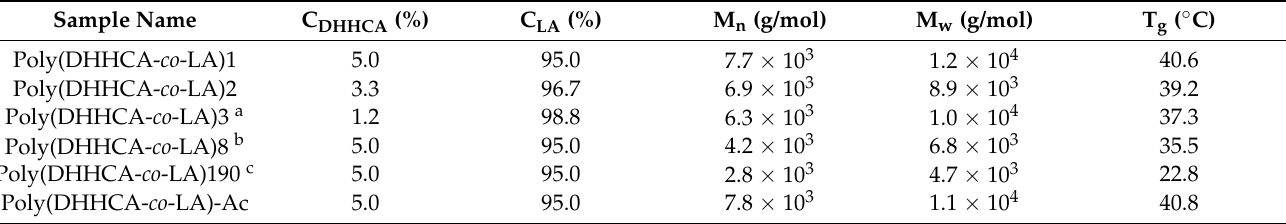
Table 1. Characterization of poly(DHHCA- co